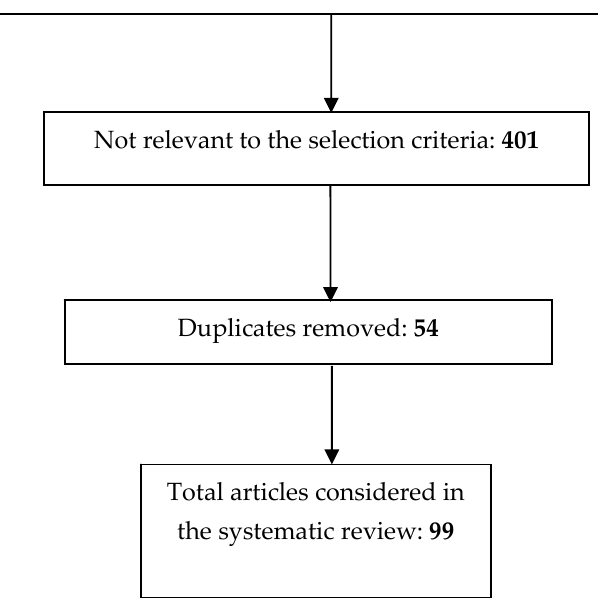
Figure 1. Overview of the article inclusion and screening process